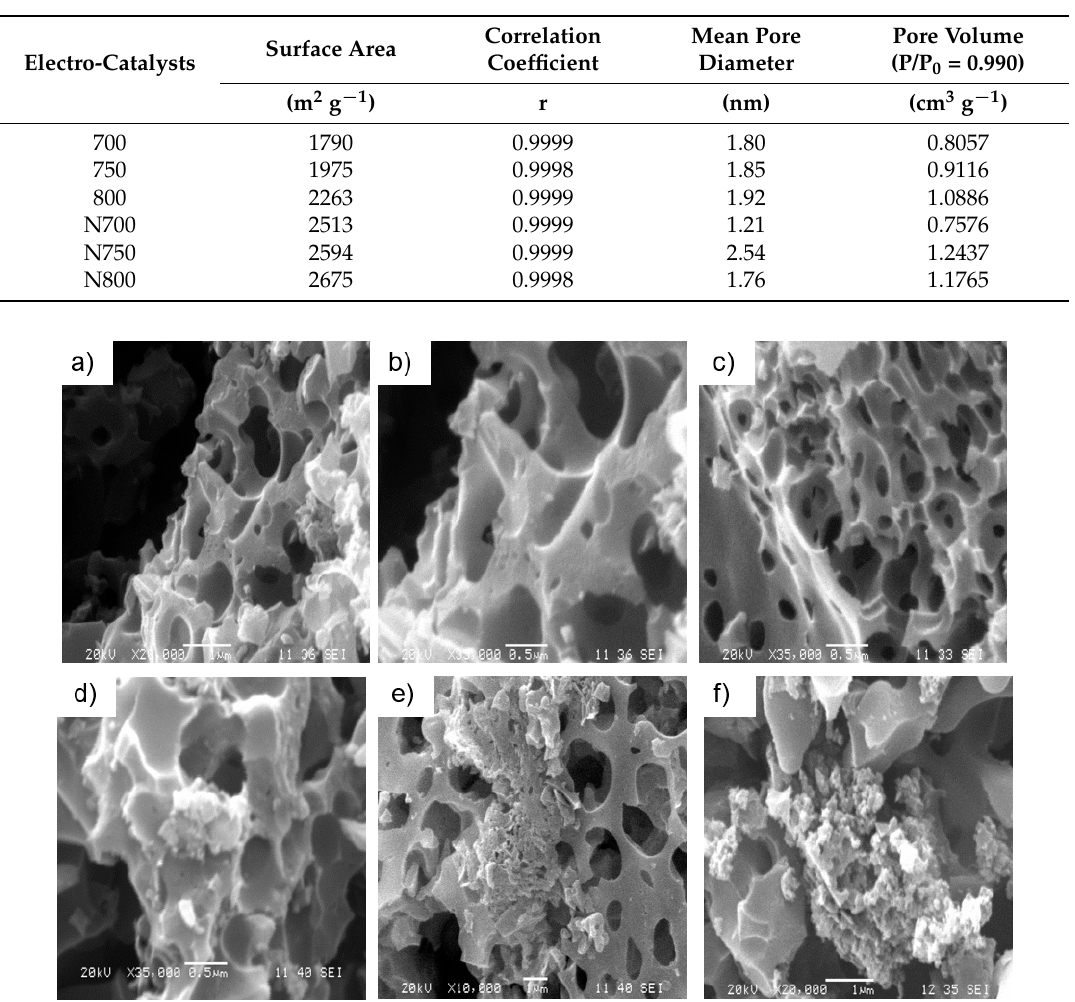
Table 3. Textural properties of the synthetized samples from Sargassum spp.